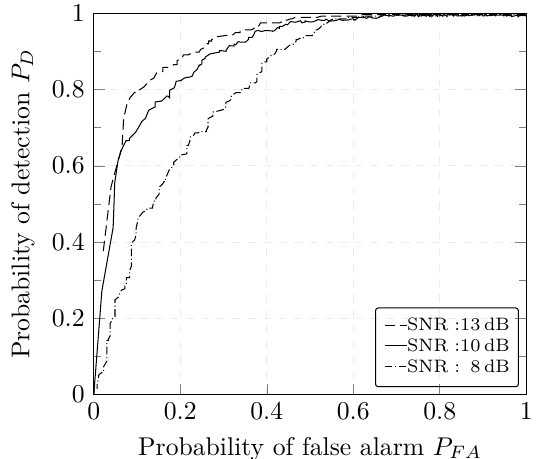
Figure 11. ROC curve of the GLRT